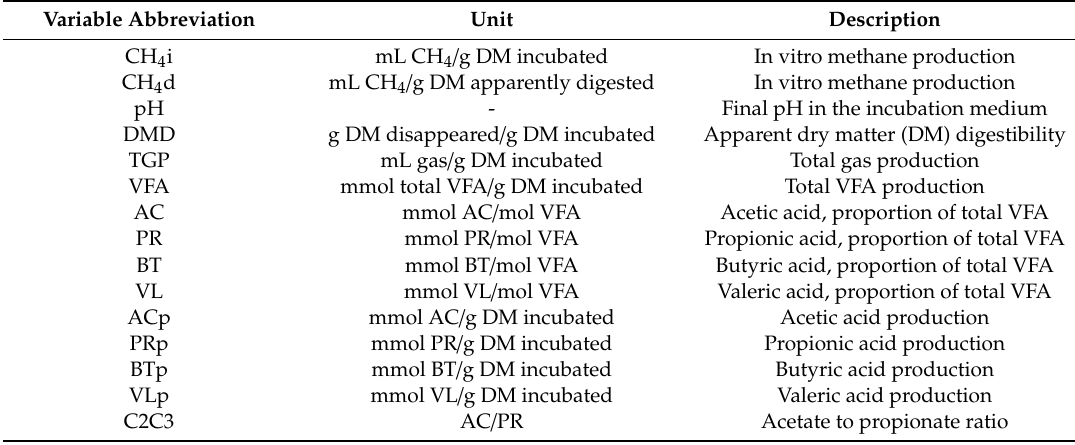
Table A1. Summary of variable abbreviations and units /